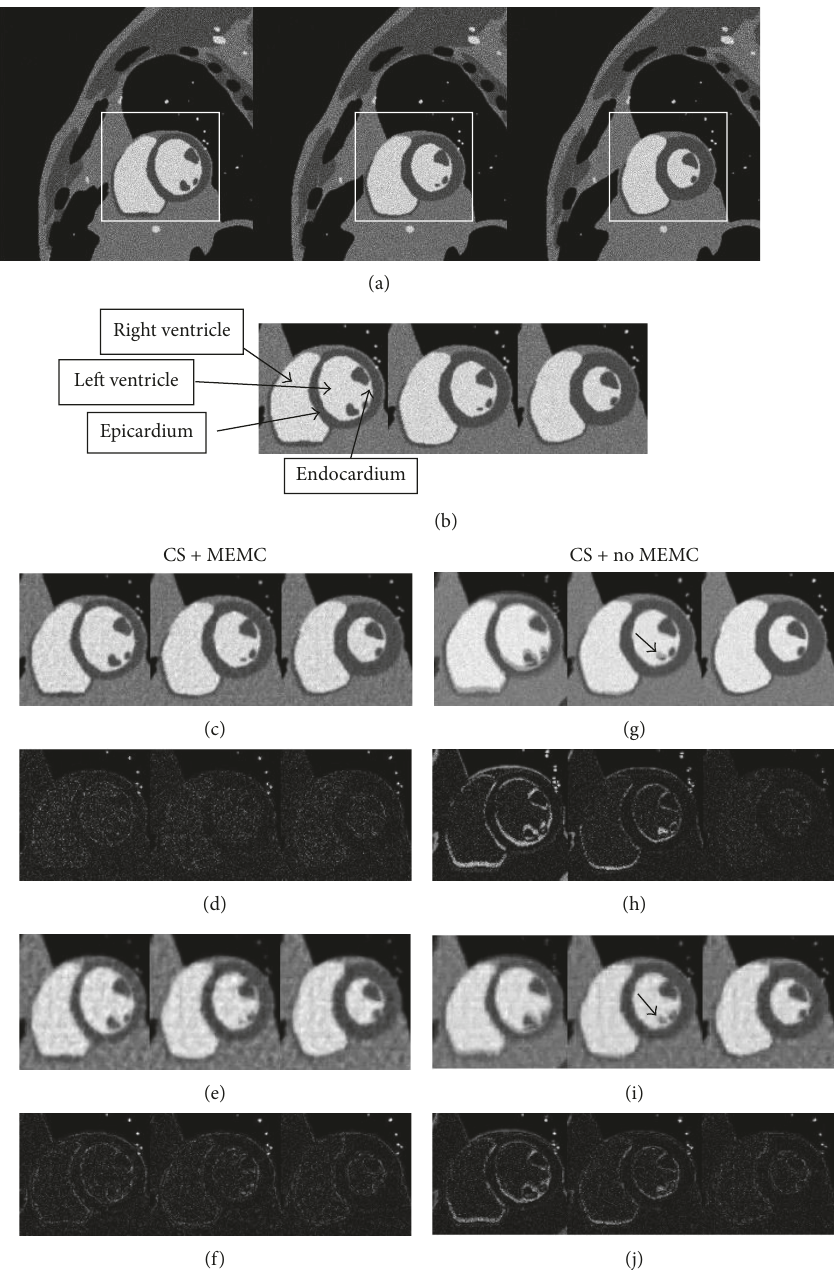
Figure 3: Comparison of recovered images with and without respiratory motion estimation for simulated data: frames 1, 5, and 12 (left to right). (a) Gold standard images from full k -space breath held data. (b) Spatial region of interest (ROI). (c) Reconstruction using the proposed technique (CS + MEMC) at 𝑅 = 2 . (d) Difference between estimated images (c) and (b). (e) Reconstruction using the proposed technique (CS + MEMC) at 𝑅 = 8 . (f) Difference between estimated images (e) and (b). (g) Reconstruction with CS + no MEMC at 𝑅 = 2 . (h) Difference between estimated images (g) and (b). (i) Reconstruction CS + no MEMC at 𝑅 = 8 . (j) Difference between estimated images (i) and